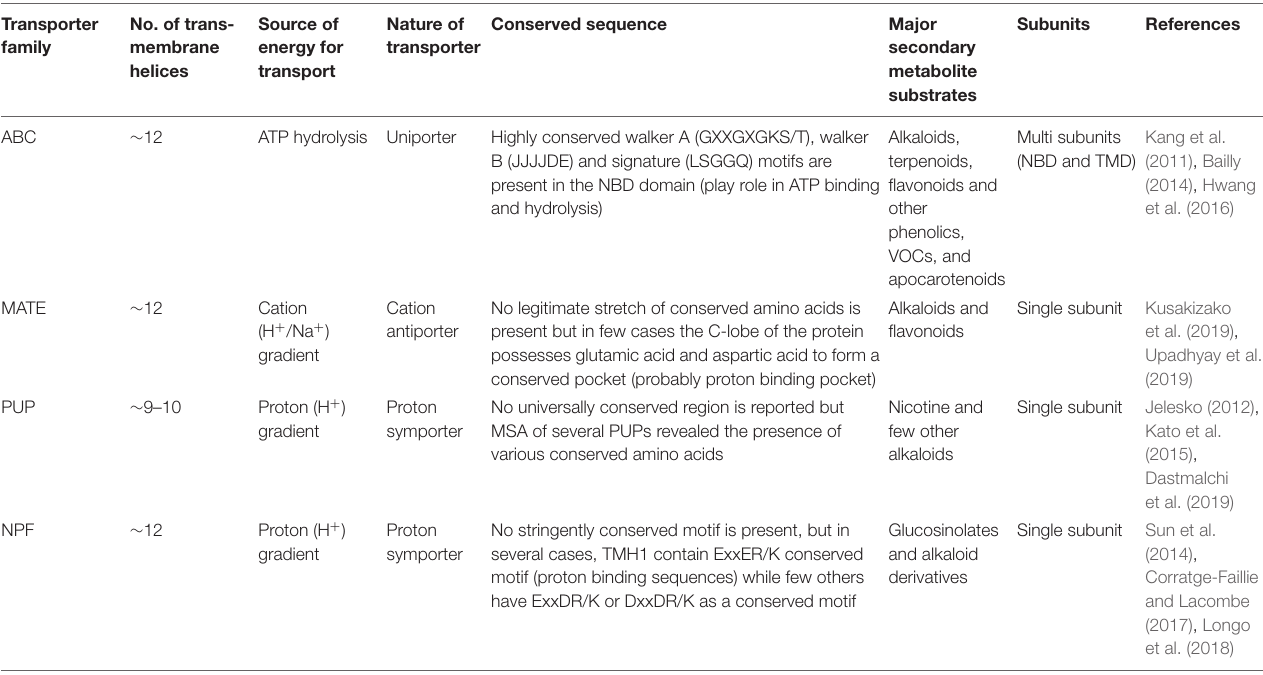
TABLE 2 | A brief comparison of structural and functional features of various transporter families. Transporter